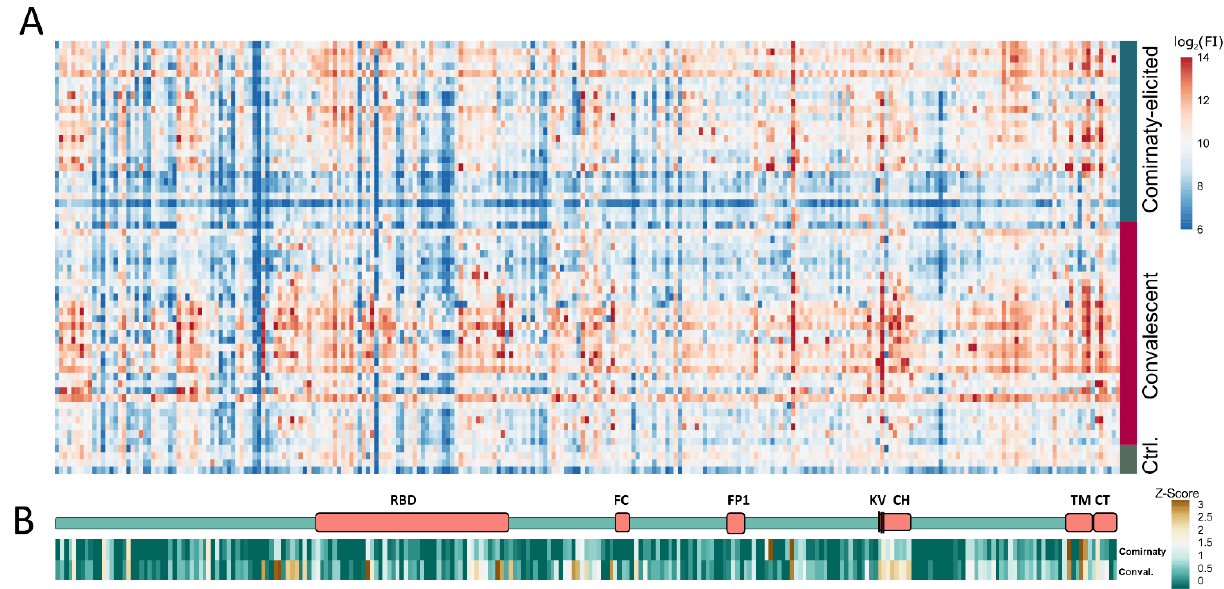
Figure 1. Mapping of linear S protein epitopes. ( A ) Heatmap of IgG antibody immune response of 31 sera from COVID-19 convalescent patients, 25 BNT162b2 vaccinated patients, and 4 healthy donors. FI: fluorescence intensity. ( B ) Schematic structure of the S protein and condensed heatmap of all 56 sera grouped in vaccinated and convalescent patients. RBD: Receptor binding domain; FC: furin cleavage site; FP: fusion peptide; KV: amino acid positions K986 and V987, which are mutated to proline in the pre-fusion stabilized S protein; CH: central helix; TM: transmembrane domain; CT: cytoplasmic tail.